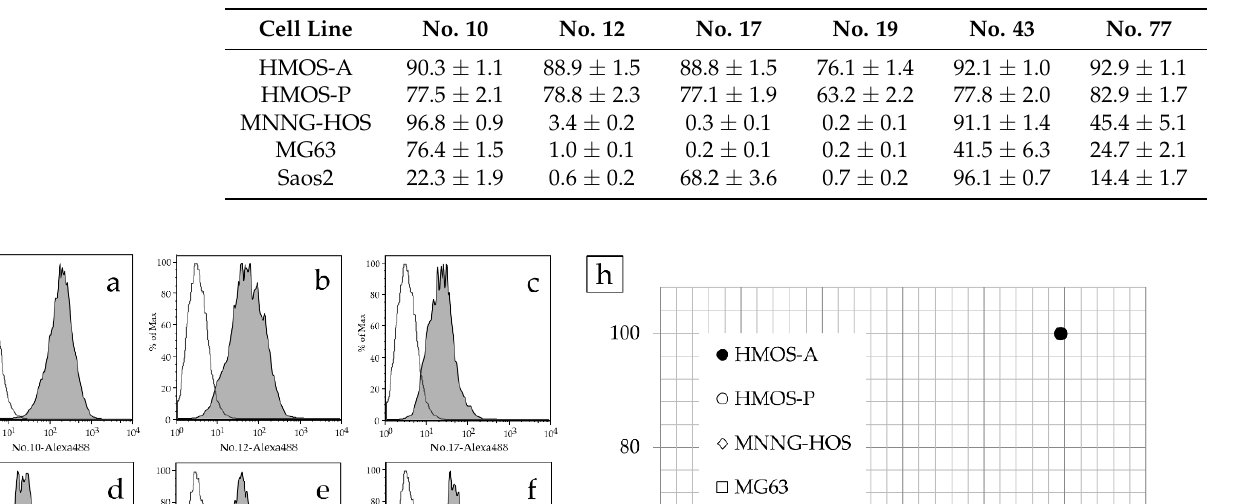
Table 1. Positivity rate of flow cytometry (FCM) for HMOS-A, HMOS-P, MNNG-HOS, MG63, and Saos2 cells.